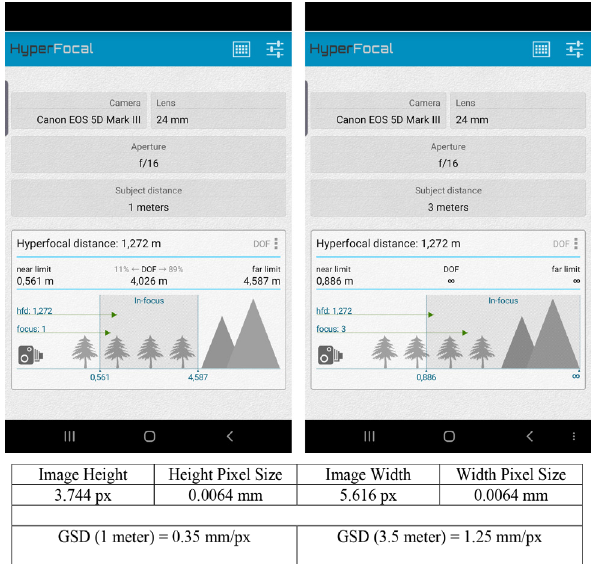
Figure 5. The calculation of the depth of field, the hyperfocal distance and the ground sampling distance